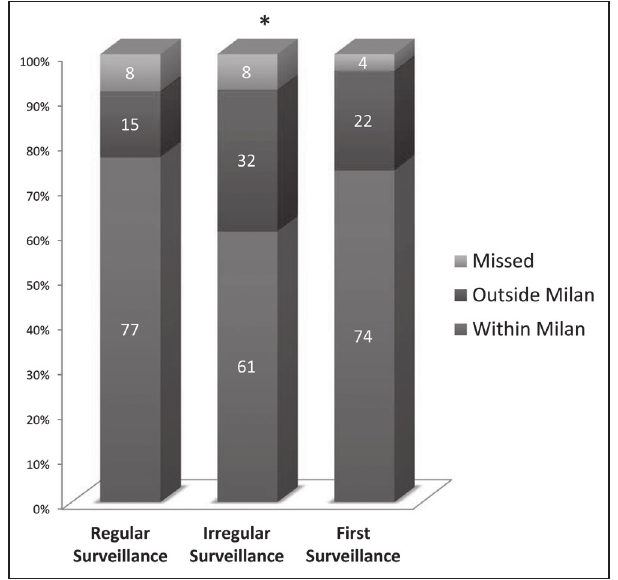
Figure 2) Hepatocellular carcinoma ultrasound intervals according to Milan criteria for liver transplantation. *Indicates statistically significant